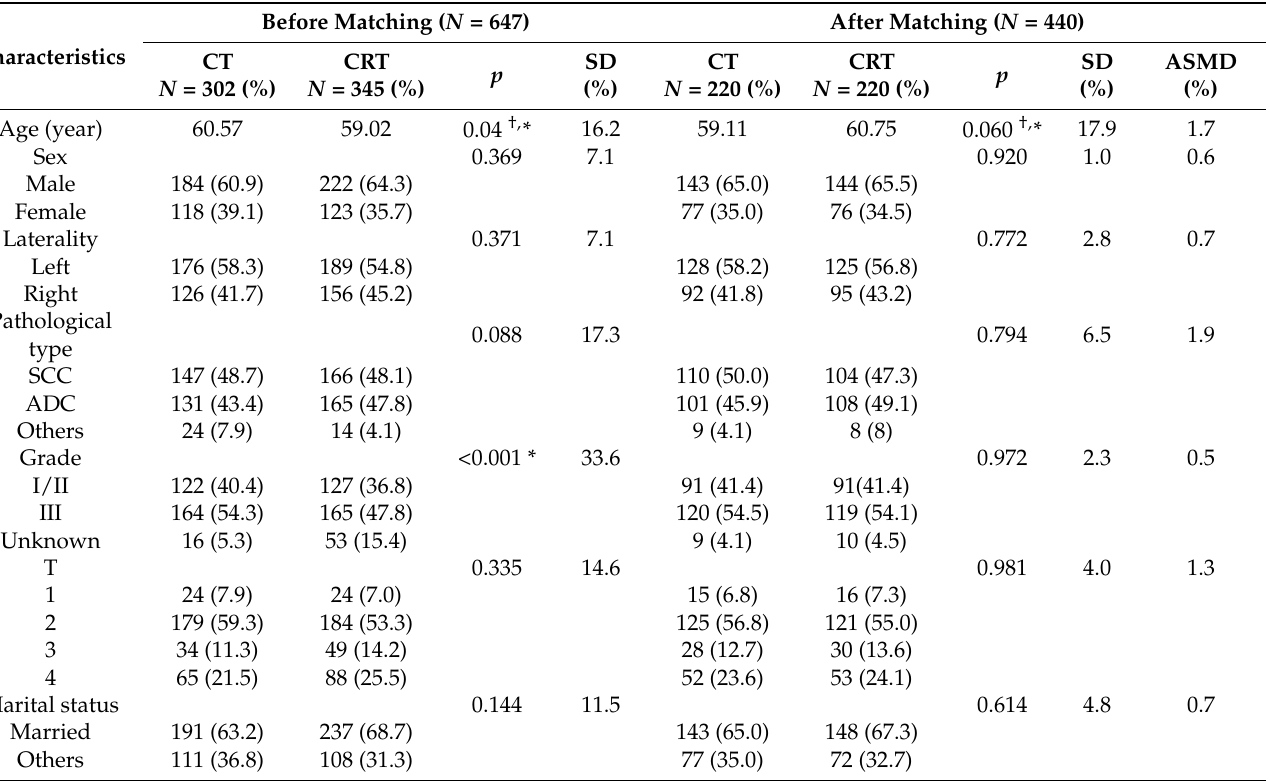
Table 3. Patient baseline characteristics by postoperative treatment before and after propensity score matching.